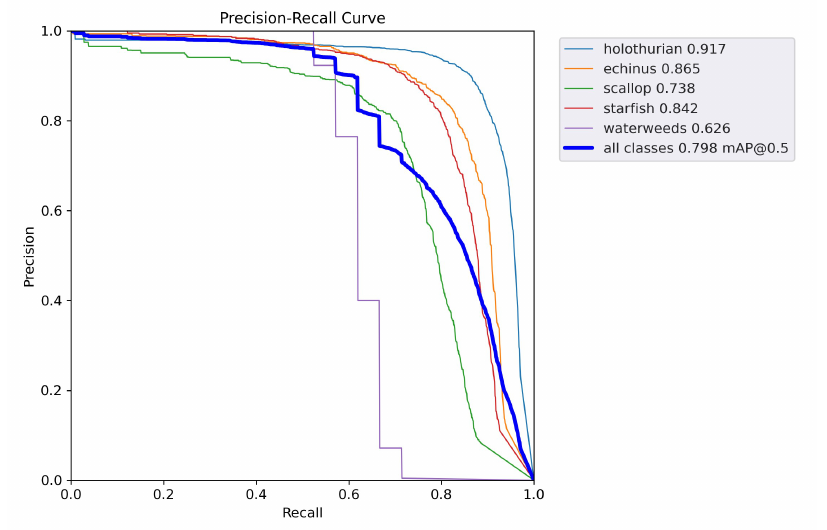
Figure 16. PR curves for the proposed